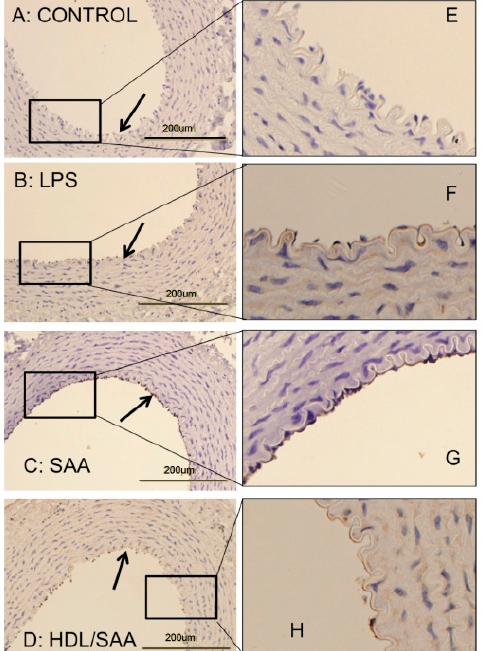
Figure 2. SAA enhanced atherosclerosis and induced early pro-atherogenic changes in VCAM-1 staining in the aortae of ApoE − / − mice, which can be prevented by HDL. Male ApoE − / − mice were randomly allocated into 4 treatment arms and administered with vehicle (control), LPS, SAA alone, or SAA in combination with HDL, as described in the methods section. Mice were sacrificed at 4 weeks, hearts perfused with PBS (50 mM, pH 7.4), then harvested. Thoracic aortae attached to the dorsal third of each heart fixed were processed for immune histological analysis. Thin sections of thoracic aorta from mice designated to the control (panel A ), LPS ( B ), SAA ( C ) groups, as well as mice pretreated with freshly isolated human HDL for 2 weeks prior to SAA administration ( D ) were incubated with anti-VCAM-1 and imaged by light microscopy (left column). Black arrows indicate the endothelial surface on the inner lumen of the artery in panels ( A – D ). Dark stained immuno-reactive VCAM-1 on the vascular endothelium is evident in Panel C, whereas it is markedly lower or absent in Panels A , B , and D . The panels in the right column ( E – H ) show a high-magnification view of corresponding boxed regions of endothelial with VCAM-1 + immuno-reactivity seen as a granular deposit on the endothelium. Data are representative of at least 3 fields of view from each section from control ( n = 6 mice), LPS ( n = 6), SAA ( n = 6), and HDL / SAA ( n =